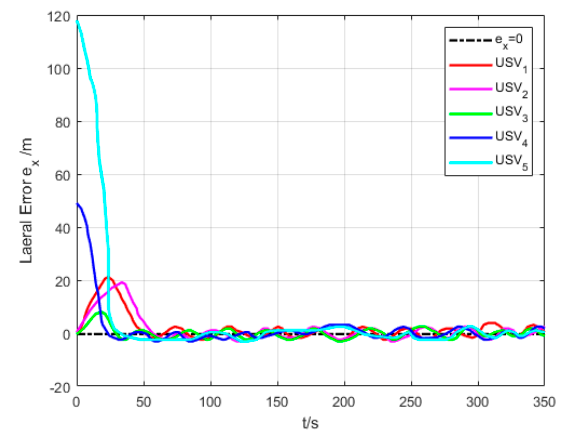
Figure 17. Formation trajectory (Algorithm 3).